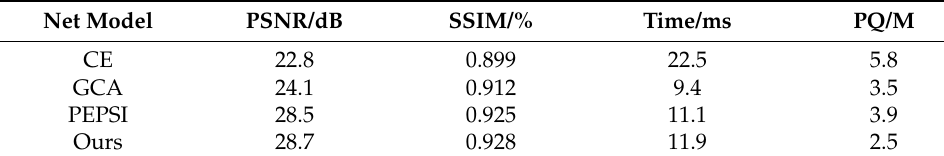
Table 4. Performance of the di ff erent inpainting methods for square masked images.